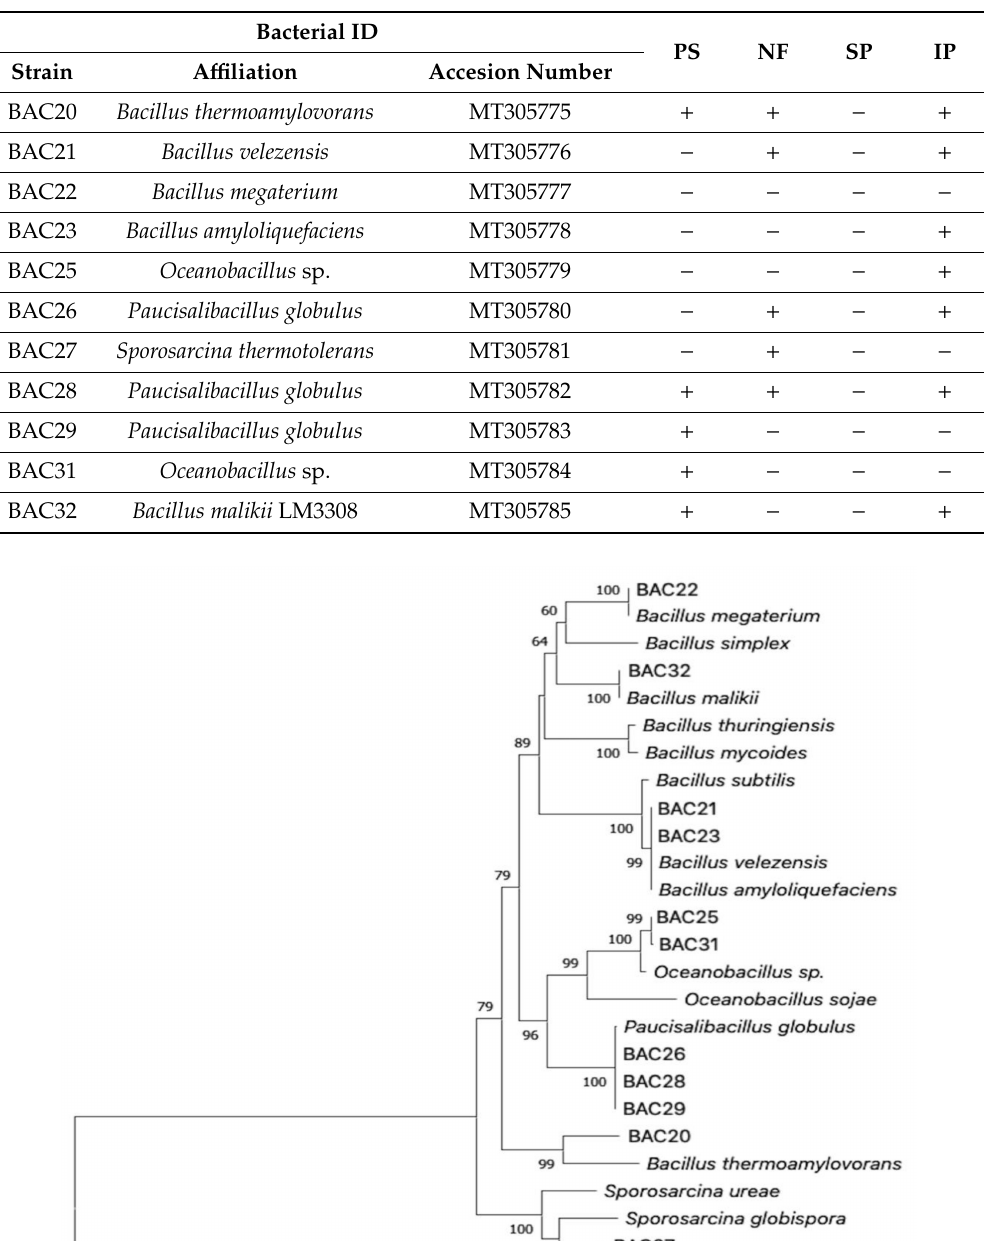
Table 4. Identification and in vitro plant growth-promoting traits of isolated strains from SOA. PS: phosphorous solubilization; NF: nitrogen fixation; SP: siderophore production; IP: indoleacetic acid (IAA) production. Symbol + : represents a positive reaction to the test; meanwhile, − : represents absent of the functional trait.